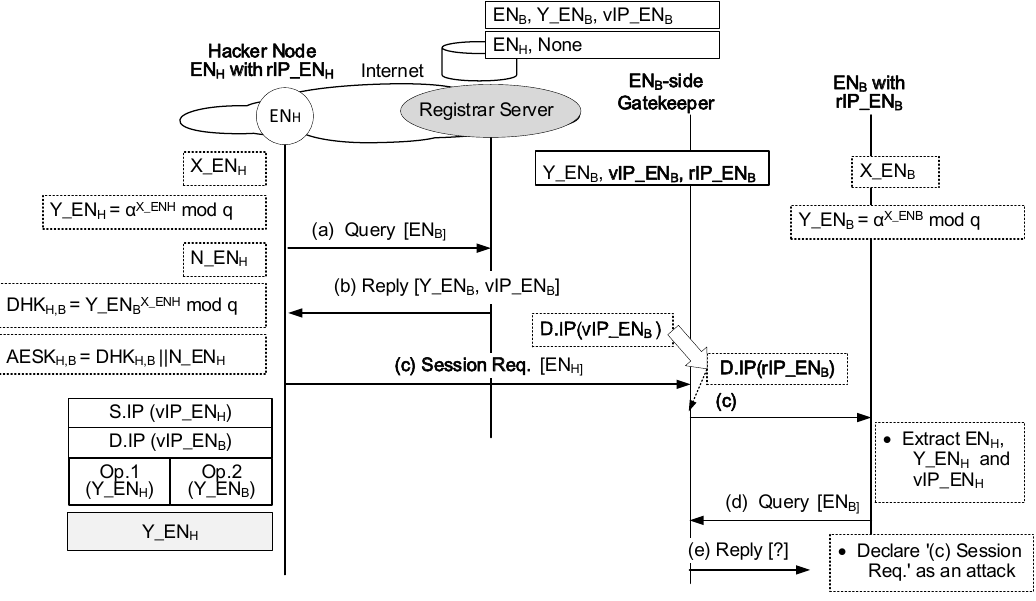
Figure 8. Effectiveness of the secure gatekeeper system against malicious session